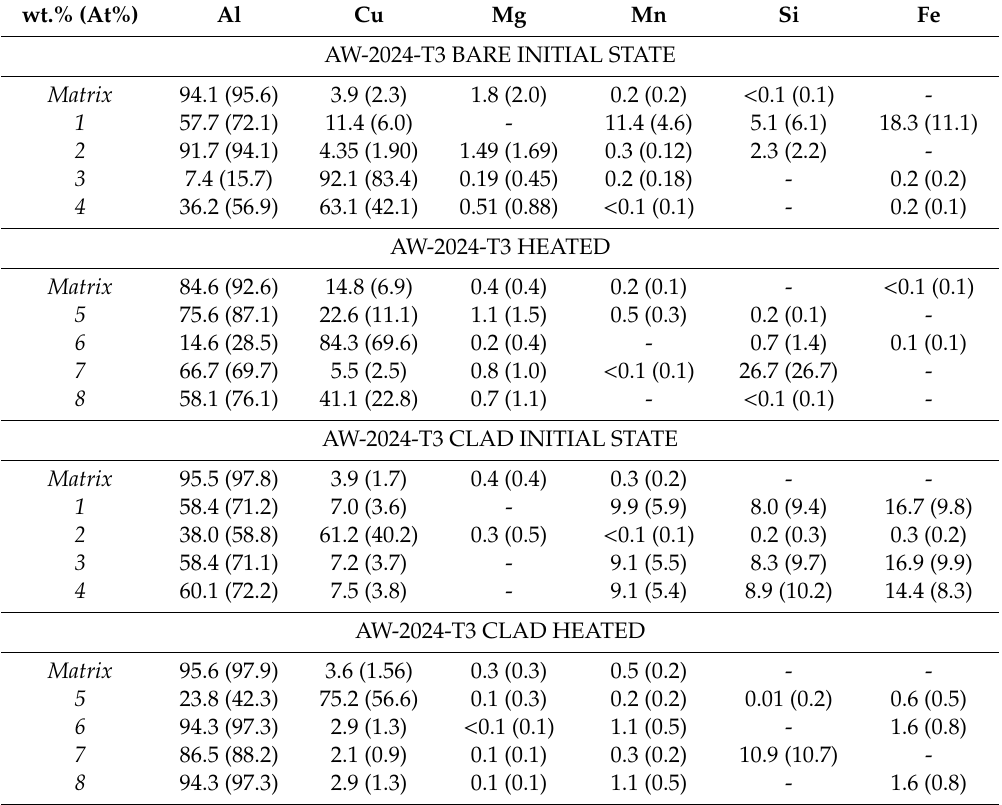
Table 3. Chemical composition (in wt.% and at.%) of matrix and intermetallic precipitations in AW-2024-T3 alloy (The numbers of the precipitations in Table 3 refer to the numbers in Figure 2. wt.%